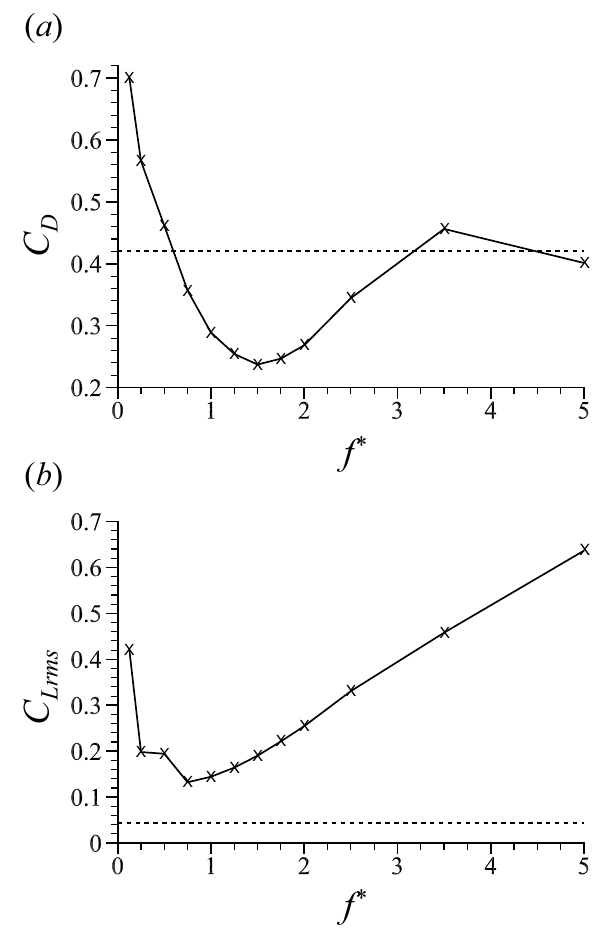
Figure 5. Variations of force coefficients versus the forcing frequency ( f ∗ ) with the fixed forcing amplitude of V 0 / u ∞ = 0.2: ( a ) mean drag coefficient ( C D ); ( b ) rms of lift coefficient fluctuations ( C Lrms ). Here, dashed line denotes values for the uncontrolled